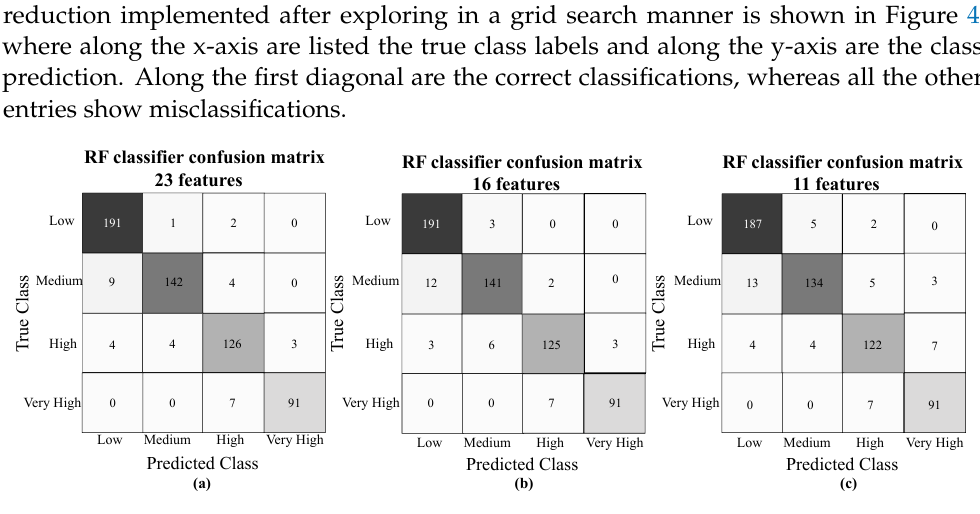
Figure 4. RF classifier confusion matrix for ( a ) 23 features, ( b ) 13 features ( c ) 11 features. Regarding the feature reduction used, it was essential to consider the feature im- portance properties for the initial RF model. The feature importance property measures a relative weight value to each feature, which represents a direct relationship with the importance of the corresponding feature for this classical machine learning model. Figure 5 presents a cumulative graph which represents the relative importance values obtained for each feature, sorted from the highest to the lowest